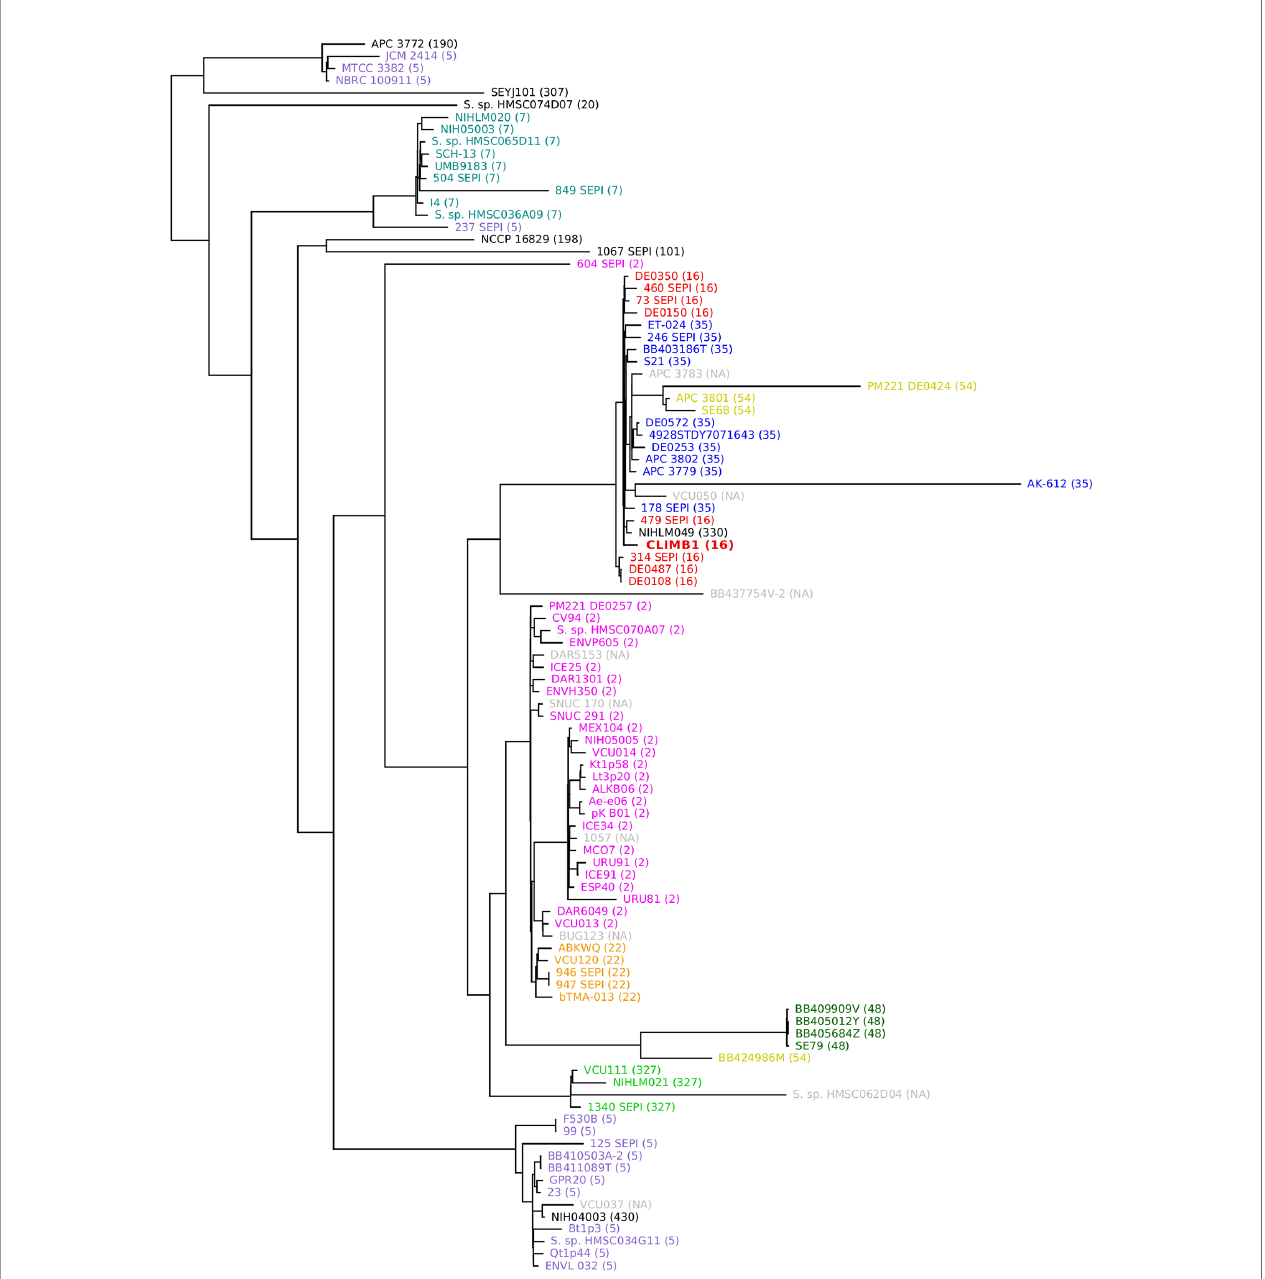
FIGURE 4 | Phylogenetic tree of S. epidermidis , including CLIMB1 (red, center) and the most similar strains with known genomes, based on genomic sequence comparison. MLST pro fi les are indicated in parentheses and by color